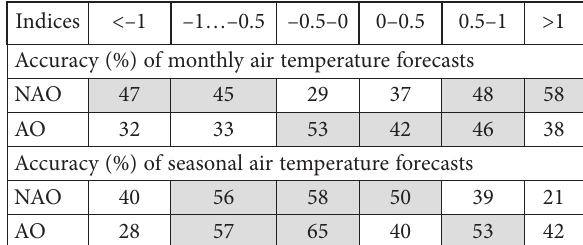
Table 2. Favourable/unfavourable NAO/AO indices intervals for the initialization of monthly and seasonal long-range air temperature forecasts for the territory of Lithuania using CFSv2. Indices leading to better-than-average accuracy (average fractions of the correct forecasts are 41% for monthly and 47% for seasonal forecasts) are depicted in light grey Indices